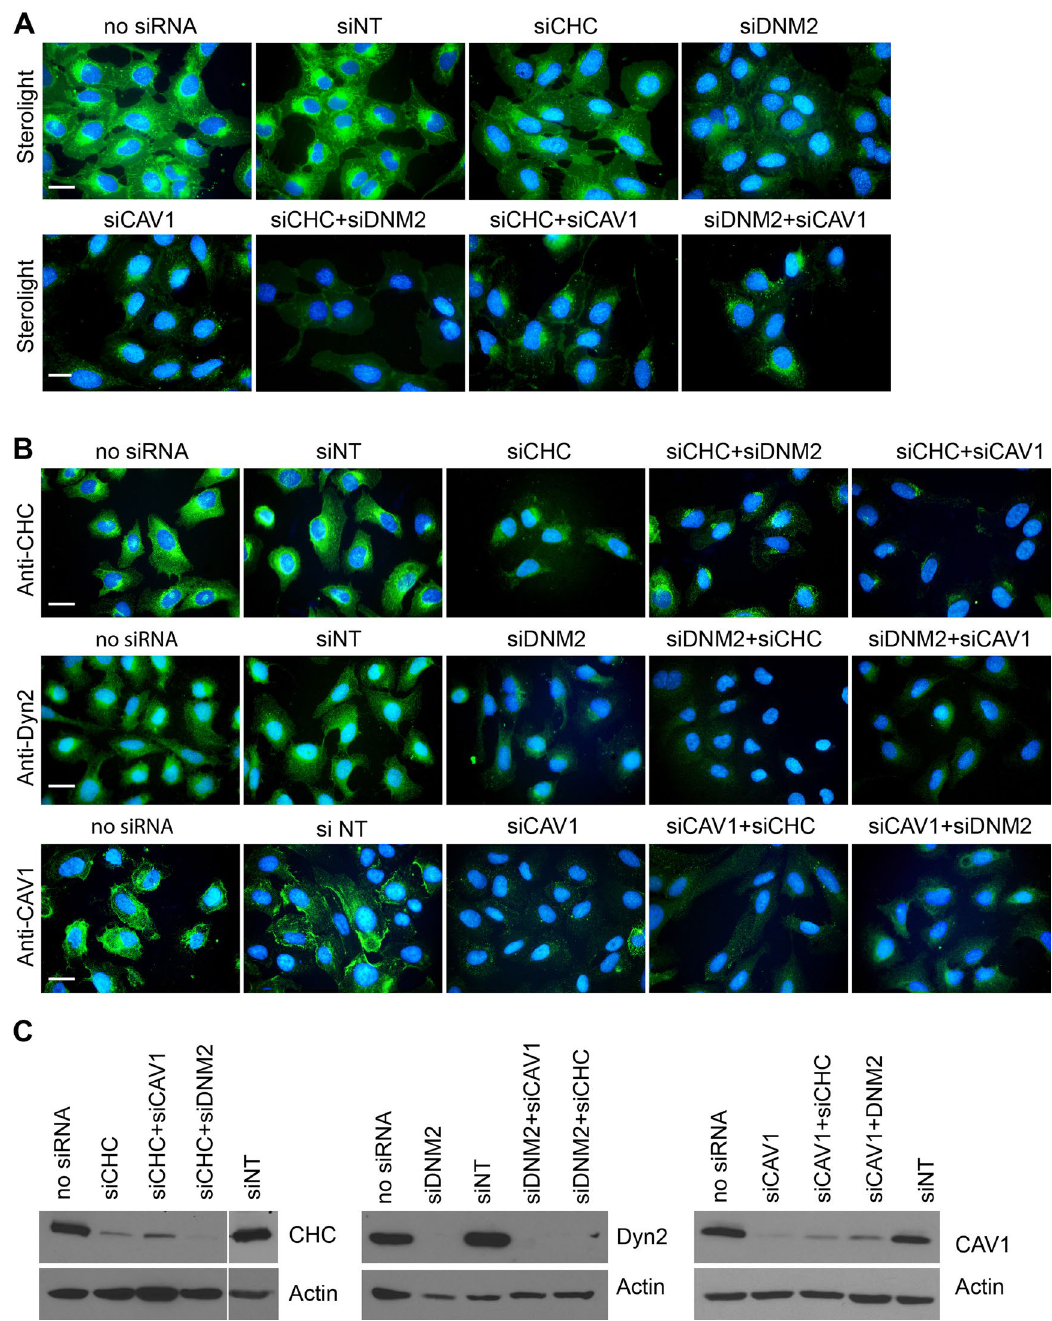
Figure 2. Knockdown of caveolin-1 and dynamin-2, unlike clathrin, leads to suppression of Sterolight uptake. U-2 OS cell were transfected with individual siRNAs targeting clathrin (siCHC), dymamin-2 (siDNM2) and caveolin-1 (siCAV1) or their combinations. ( A ) Transfected cells with silenced expression of specified genes were pulsed with Sterolight probe (1 µg/ml) for 1 min and after 30 min, nuclei of cells were labelled with Hoechst and fluorescence was recorded. For comparison were included cells subjected to transfection procedure without siRNA (no siRNA) or cells transfected with non-targeting siRNA (siNT) as a negative control. ( B , C ) The expression of targeted genes was assessed after 96 h by immunostaining with specific antibodies ( B ) or cell lysates were subjected to Western blot analysis ( C ) to confirm that siRNAs effectively reduced protein expression. For spatial reasons, only cropped parts of membranes with bends of corresponding proteins are shown. Full-length membranes with marked edges are presented in Supplementary Information in Fig. S3. The same membranes were subsequently re-probed for actin to verify equal protein loading (lower panel). Cell nuclei were stained with Hoechst for 5 min. Scale bar 10